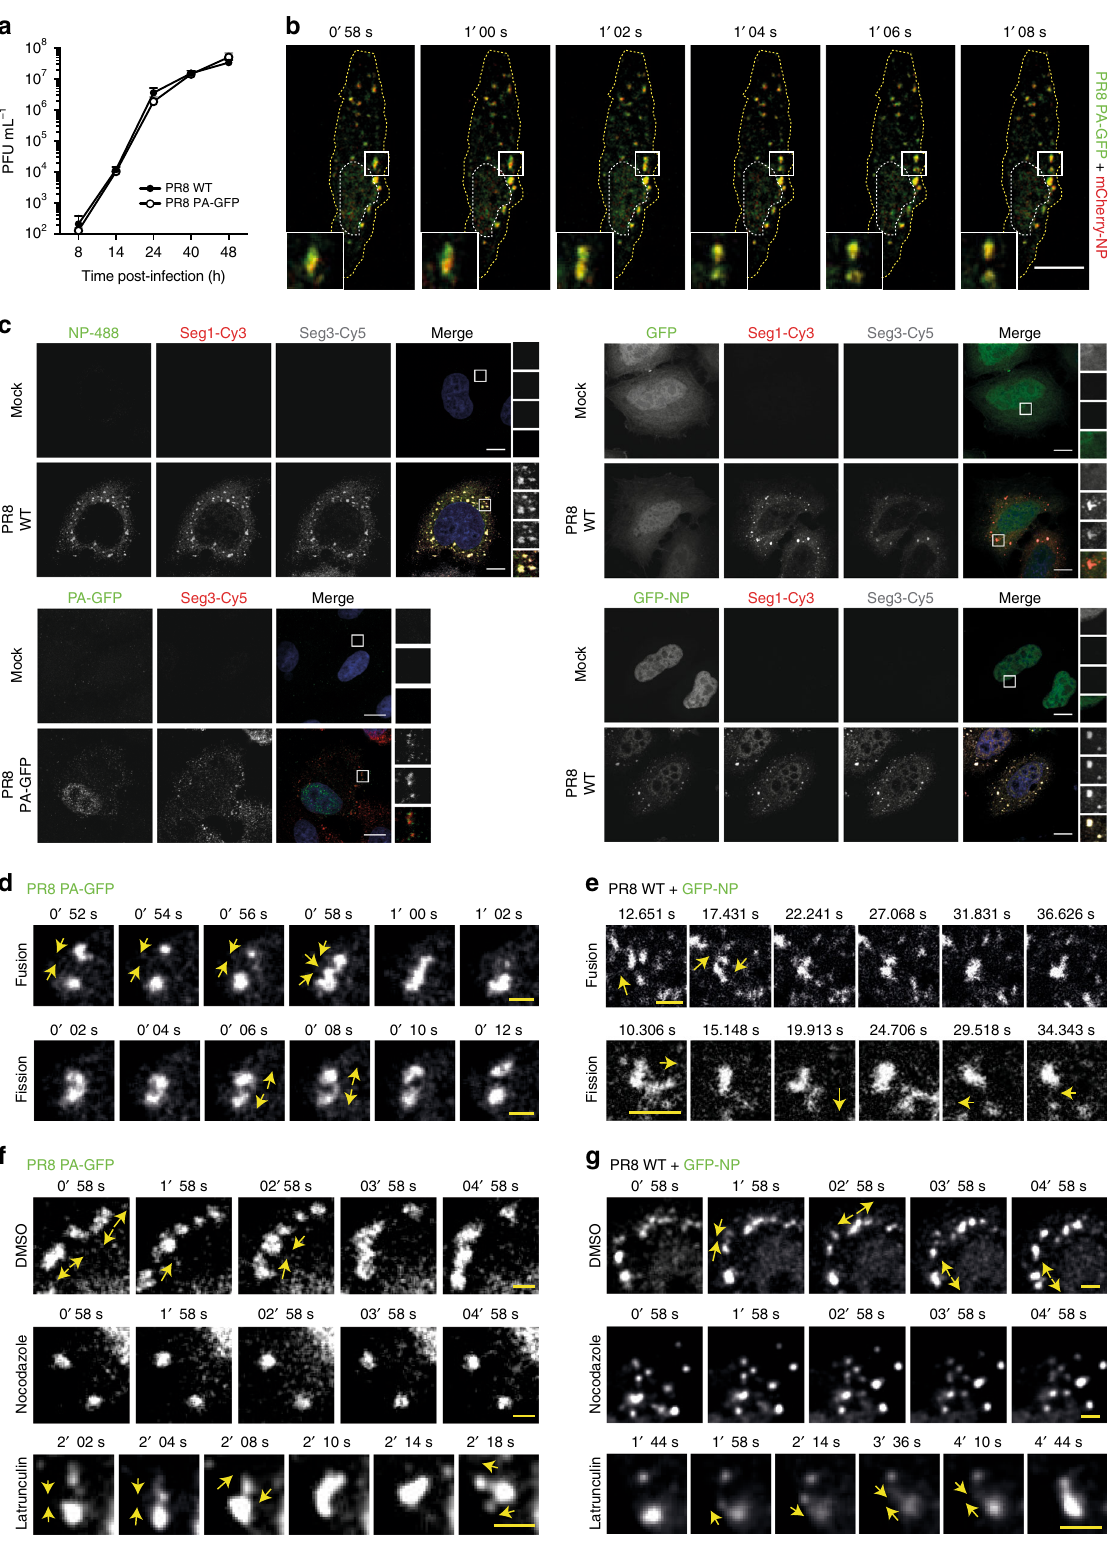
Biomolecular condensates exhibit diverse physical properties, ranging from liquid-like to solid-like behaviors. Liquid- and solid- like condensates are morphologically similar, but can be differentiated by careful usage of the aliphatic alcohol 1,6- hexanediol 35 . We observed that viral inclusions are sensitive to a